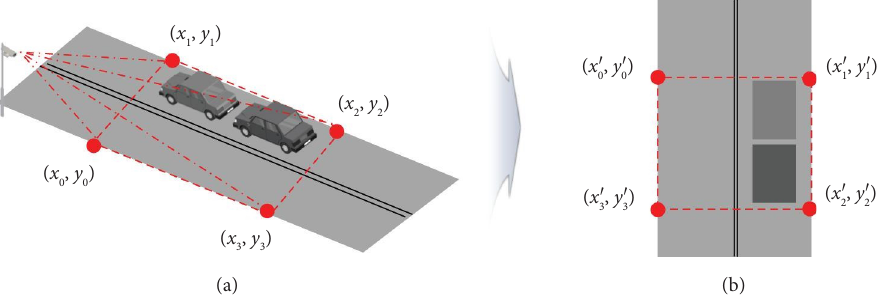
Figure 3: Perspective transformation: (a) coordinates from video surveillance systems and (b) overhead perspective